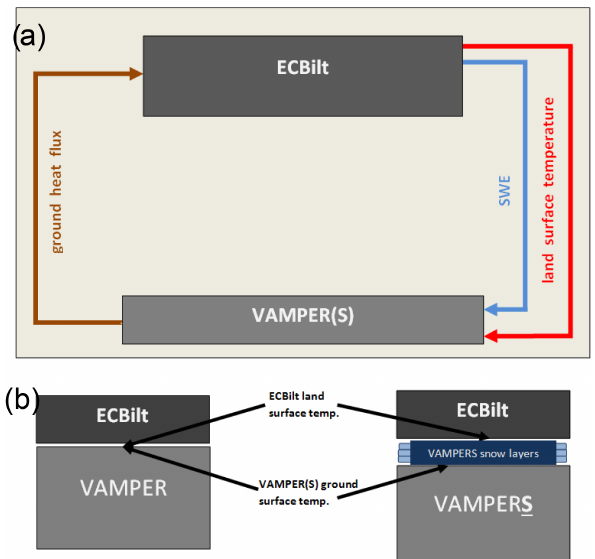
Figure 3. (a) Future i LOVECLIM coupling scheme between EC- Bilt and the VAMPER(S) model showing the variables (land sur- face temperature, snow water equivalent (SWE), and ground heat flux) passed between the components at each time step. (b) Land surface temperature of ECBilt and ground surface temperature of VAMPER(S).